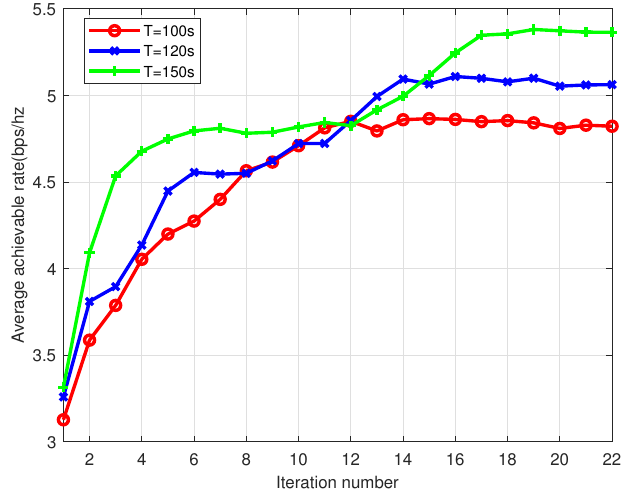
Figure 9. Convergence plot of Algorithm 1 for multi-UAV scenario under different flight duration T